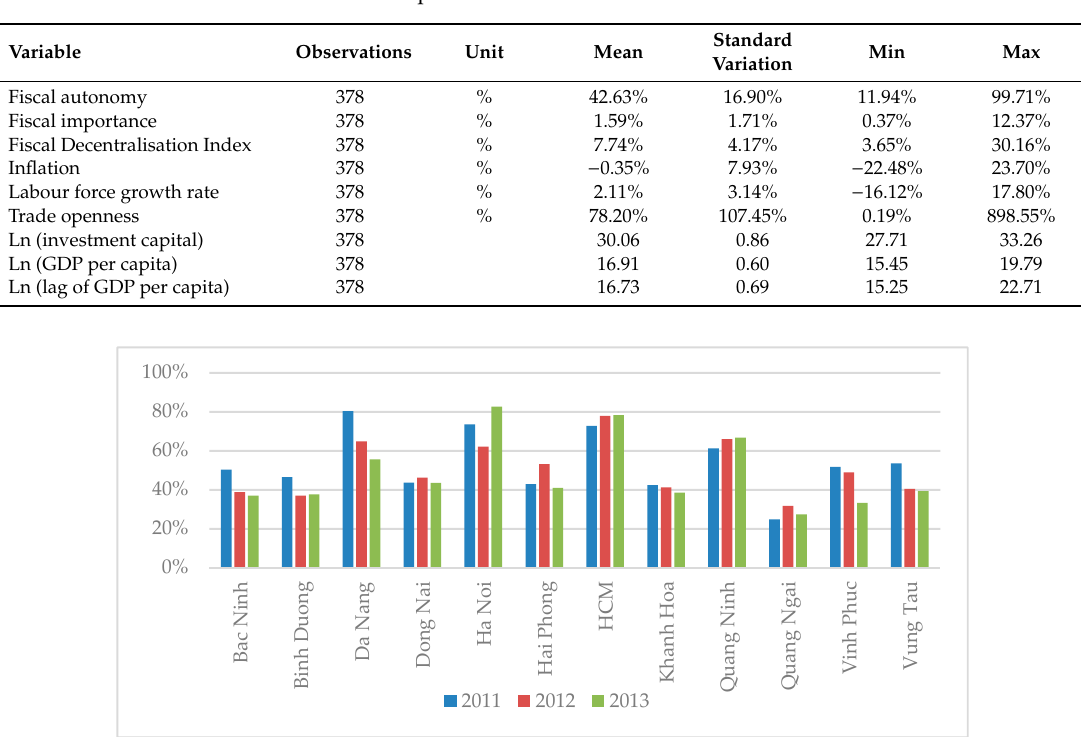
Table 2. Descriptive statistics of variables in the model.